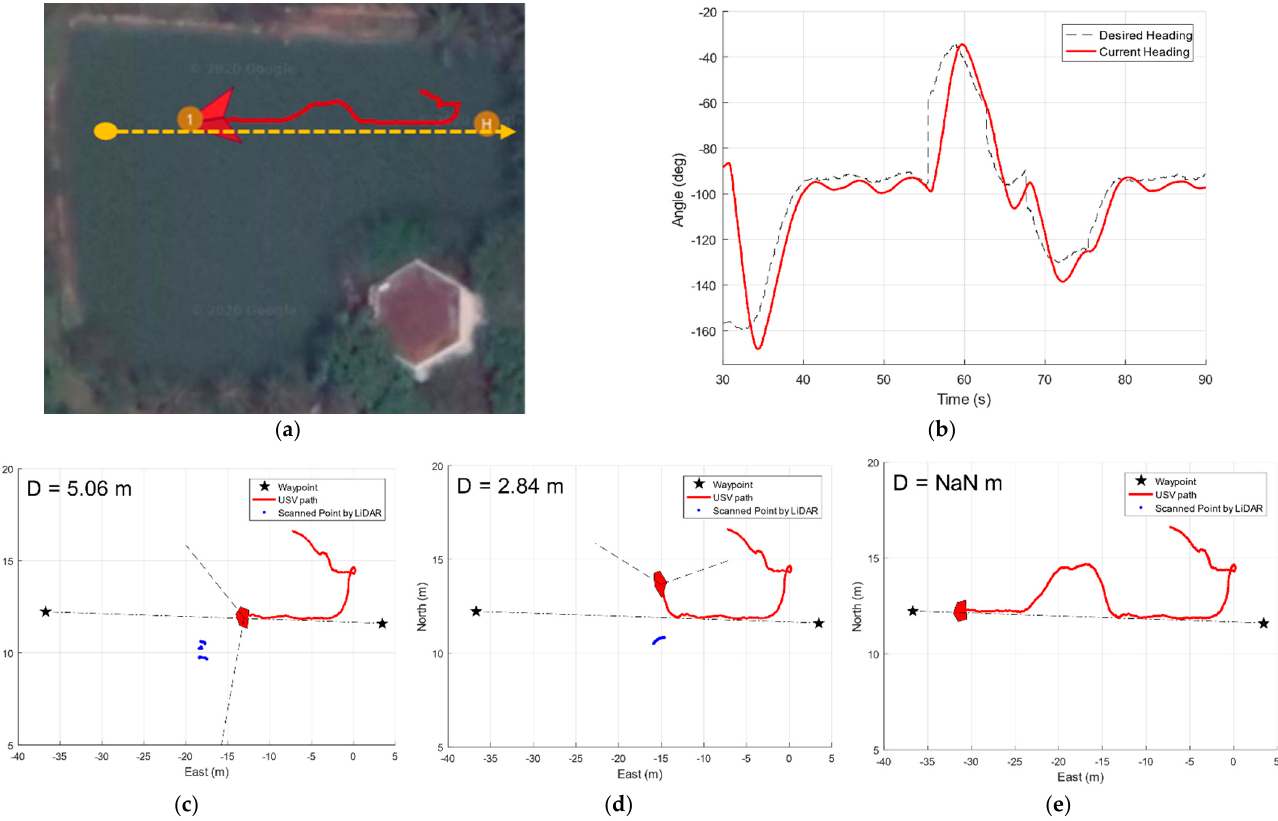
Figure 18. Dynamic obstacle avoidance in case of head-on: USV2000 ′ s path (red) and obstacle’s path (yellow) are shown in ( a ); heading-tracking analysis in ( b ); obstacle avoidance process with evolving pair of avoiding directions (black) in ( c – e ).